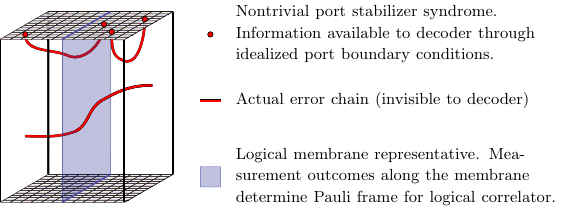
FIG. 31. Without port stabilizers, it would not be possible to associate a sensible fault distance with independent logical blocks. For any choice of the logical correlator, there would be low-weight fault configurations that result in undetectable errors on the logical correlator. Incorporating stabilizer outcomes local to the ports is an idealization that allows us to evaluate sensi- ble fault distance and fault-tolerance properties for the proposed logical